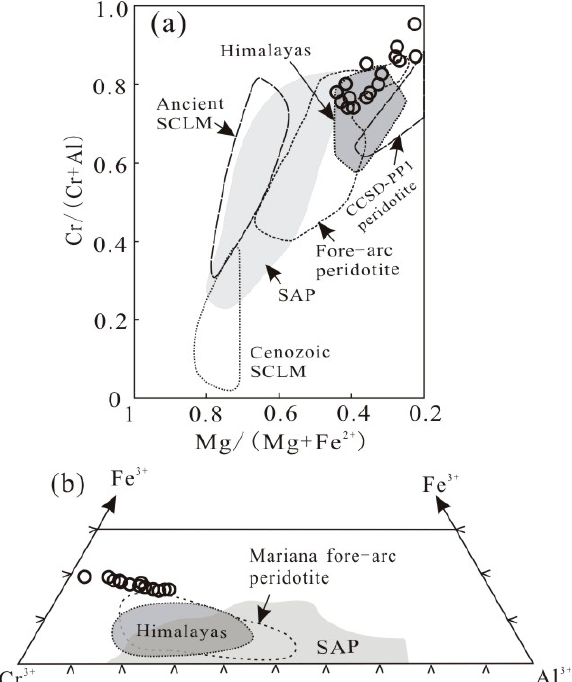
Figure 8. Plots of Cr/(Cr + Al) vs. Mg/(Mg + Fe 2+ ) ( a ) and Cr-Al-Fe 3+ ( b ) for chromite in dunite of Hujialin. Data sources: forearc peridotite [45], Mariana fore-arc peridotite [46], Himalayan forearc mantle peridotite [47], and sub-arc peridotite (SAP) [48]. Fields of ancient and Cenozoic SCLM beneath the North China Craton, as well as CCSD-PP1 peridotite, are based on Xie et al. [2] and references therein.